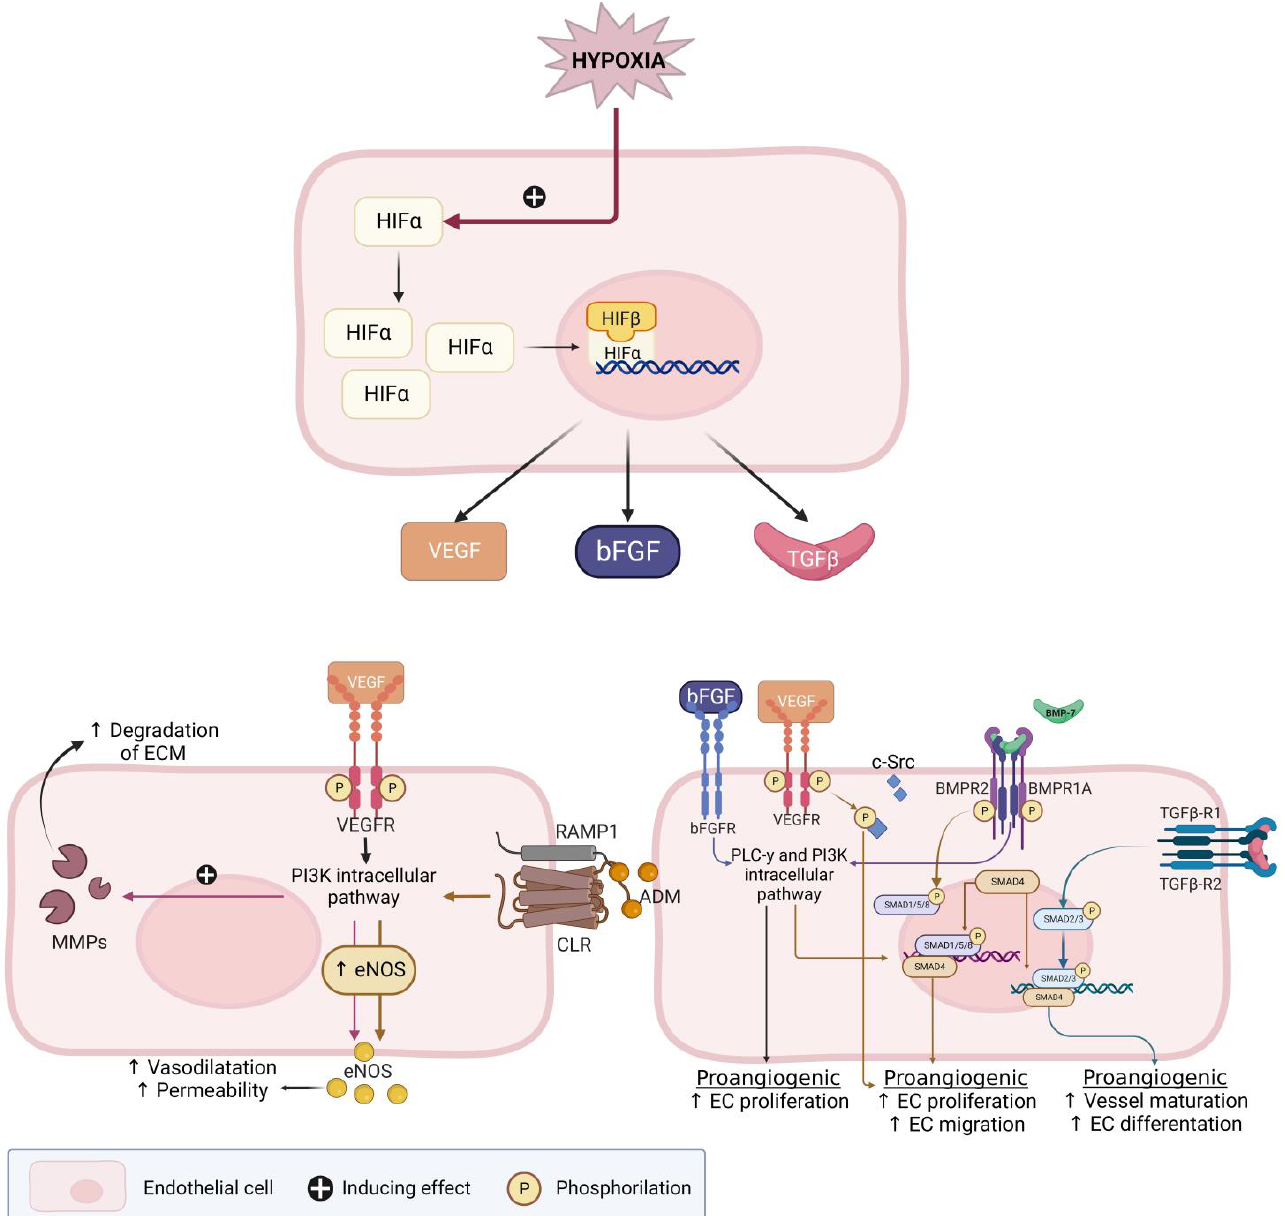
Figure 3. Hypoxia-inducible factor (HIF)-pathway and its effect on several pro-angiogenic factors. Adapted from a Middelkoop et al. 2023—Created with BioRender.com [25]. Figure legend: ↑ (upward arrow): indicates an increased process; e.g., an increased vasodilatation; ADM: adrenomedullin; bFGF: basic fibroblast growth factor; BMP(R): bone morphogenetic protein (receptor); CLR: calcitonin receptor-like receptor ; c-Src: cellular Src; EC: endothelial cell; ECM: extracellular matrix; eNOS: endothelial nitric oxide synthase; FGF-R: FGF-receptor; HIFα/β: Hypoxia inducible factor; MMP: matrix metalloproteinases; NO: nitric oxide; PLC-γ: Phosphoinositide phospholipase C— pathway; PI3K: phosphoinositide 3-kinase—pathway; RAMP: receptor-activity-modifying proteins; Smad: Suppressor of mothers against decapentaplegic; TGF-β(R)1/2: transforming growth factor-β (receptor) 1 or 2; VEGF(R): vascular endothelial growth factor (receptor).